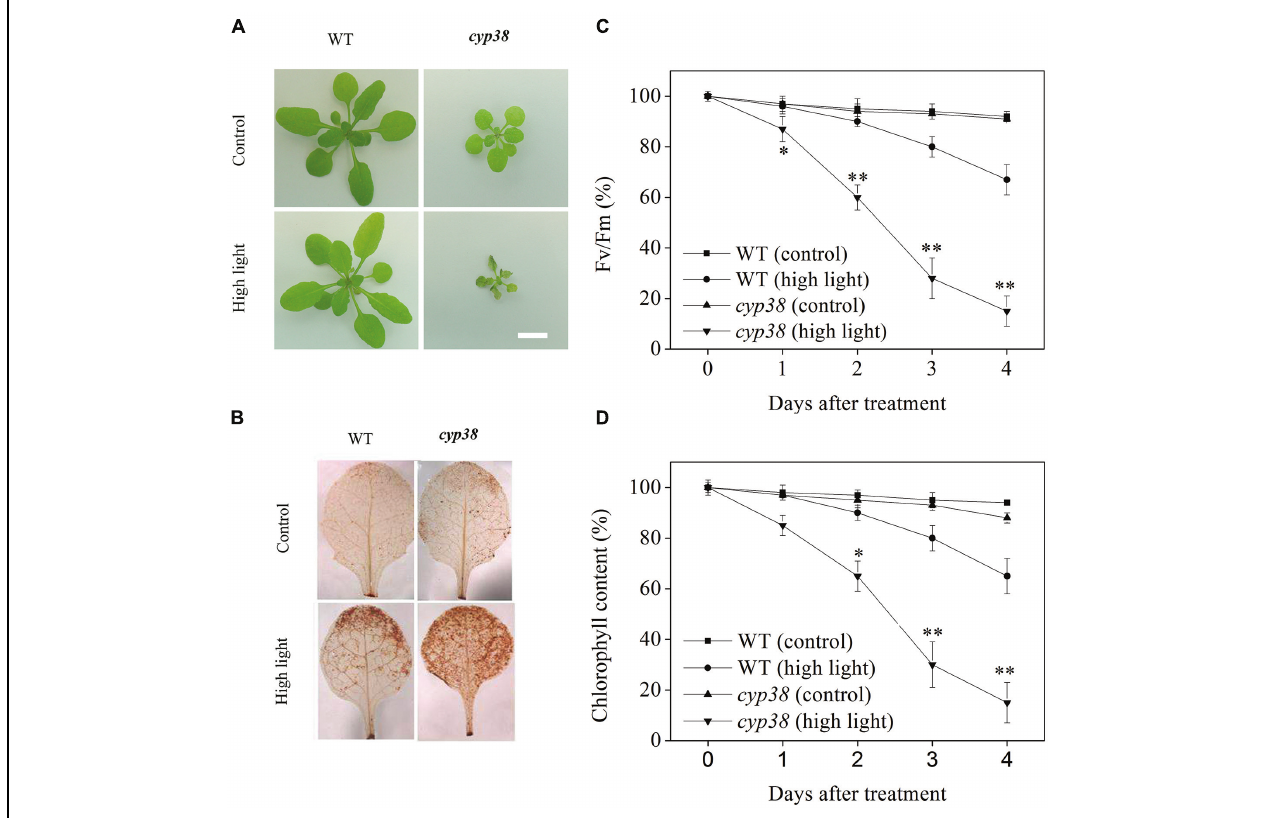
FIGURE 1 | The cyp38 mutant shows defect in photosynthesis compared with WT plants. (A) Phenotype of WT plants and cyp38 mutant plants with or without high light (HL) treatment (scale bar = 1 cm). (B) DAB staining of Arabidopsis leaves from (A) . (C,D) Photochemical efficiency and chlorophyll content of detached leaves from WT and cyp38 mutant with or without HL treatment at indicated times. Fv/Fm, maximum quantum yield of PSII electron transport (maximum variable fluorescence/maximum yield of fluorescence). Asterisks ( ∗ ) indicate a significant difference from the Control at ∗ P < 0.05, ∗∗ P < 0.01. Error bars are ± SD values for three